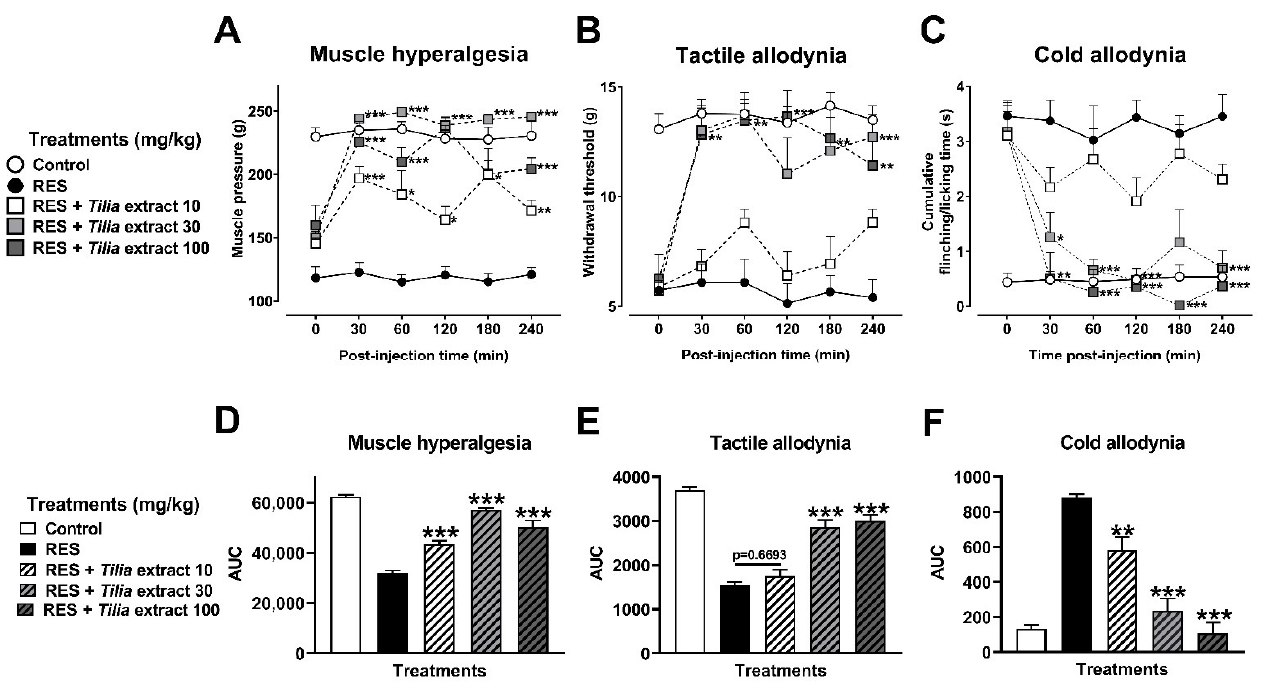
Figure 4. Antihyperalgesic and antiallodynic effect of the Tilia extract on the reserpine (RES)-in- duced nociceptive threshold. Time-course curves of the threshold for muscle pressure, shown as the force in grams supported in the right gastrocnemius muscle ( A ), the tactile response, shown as the force in grams supported on the plantar surface of the right hind limb ( B ), and cold allodynia, shown as the cumulative response time to cold stimulus (acetone) on the dorsal surface of the right hind limb for 1 min ( C ). Area under the curves of the muscle pressure threshold ( D ), tactile response ( E ), and cold allodynia ( F ). One-way ( D – F ) or two-way ( A – C ) ANOVA followed by Tukey´s test, * p <